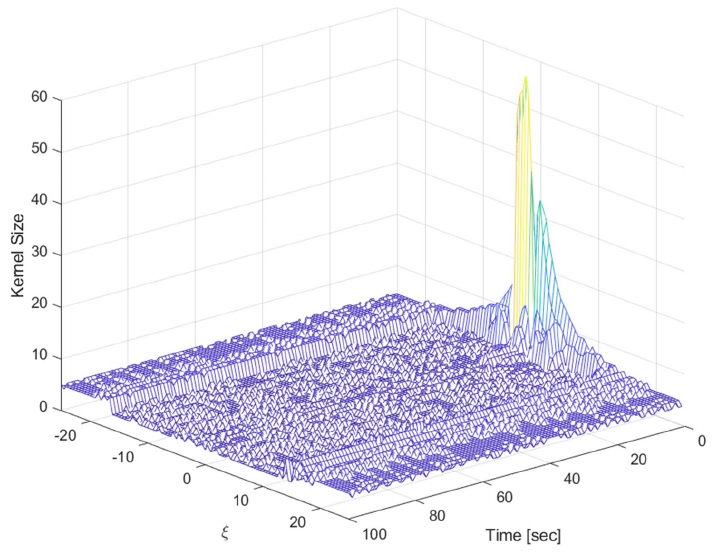
Figure 10. Kernel length profile for the growth model with the two unknown